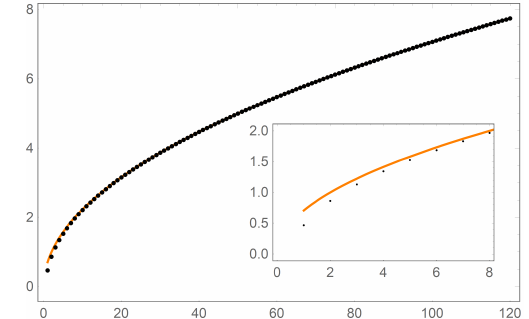
Figure 18. Maximum of the radial function along the p th symmetry angles. The maximum values (cid:113) p (black dots) closely follow y = (orange curve). The inset shows that for low values of p there is 2 (cid:113) p deviation from y = 2